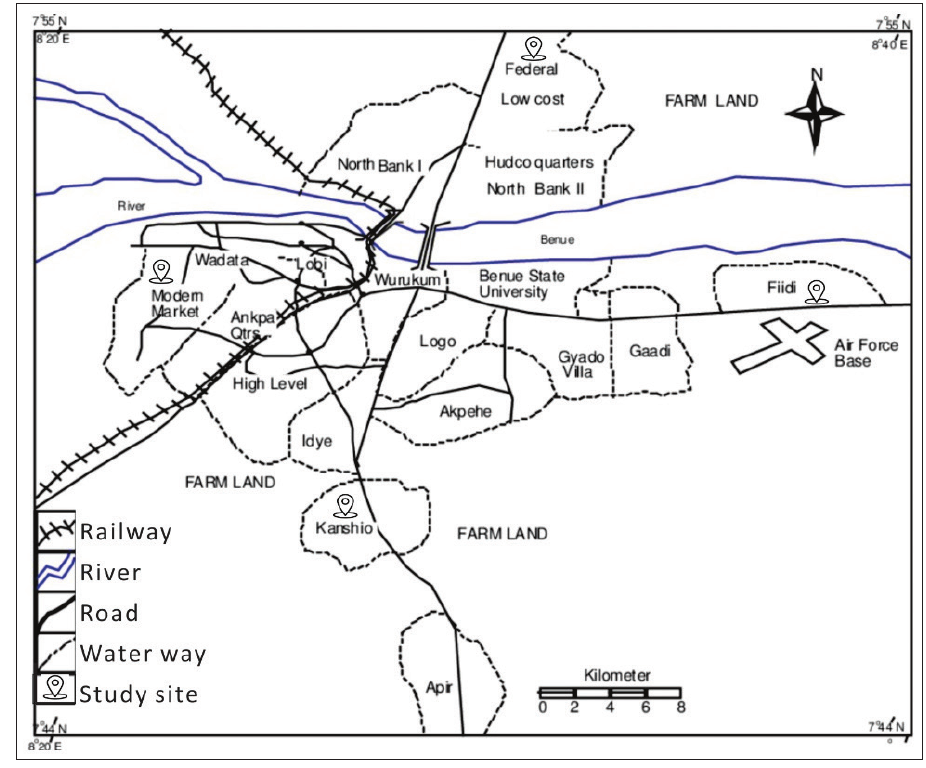
Figure-1: Map of the area of study [Source: Ministry of Land and Survey, Makurdi, Benue State, 2019